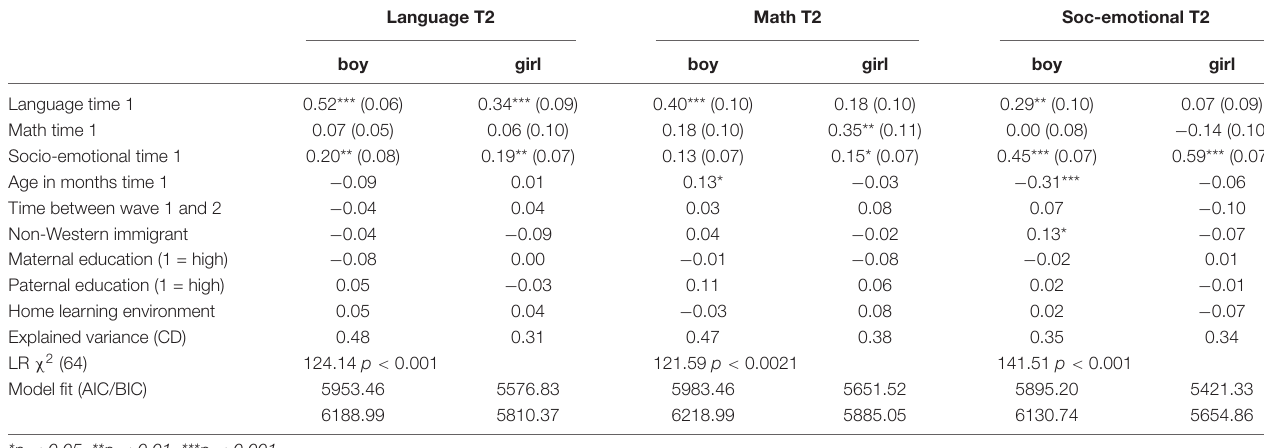
TABLE 4 | Standardized regression coefficients of the path analyses for boys ( N = 293) and girls ( N = 284).